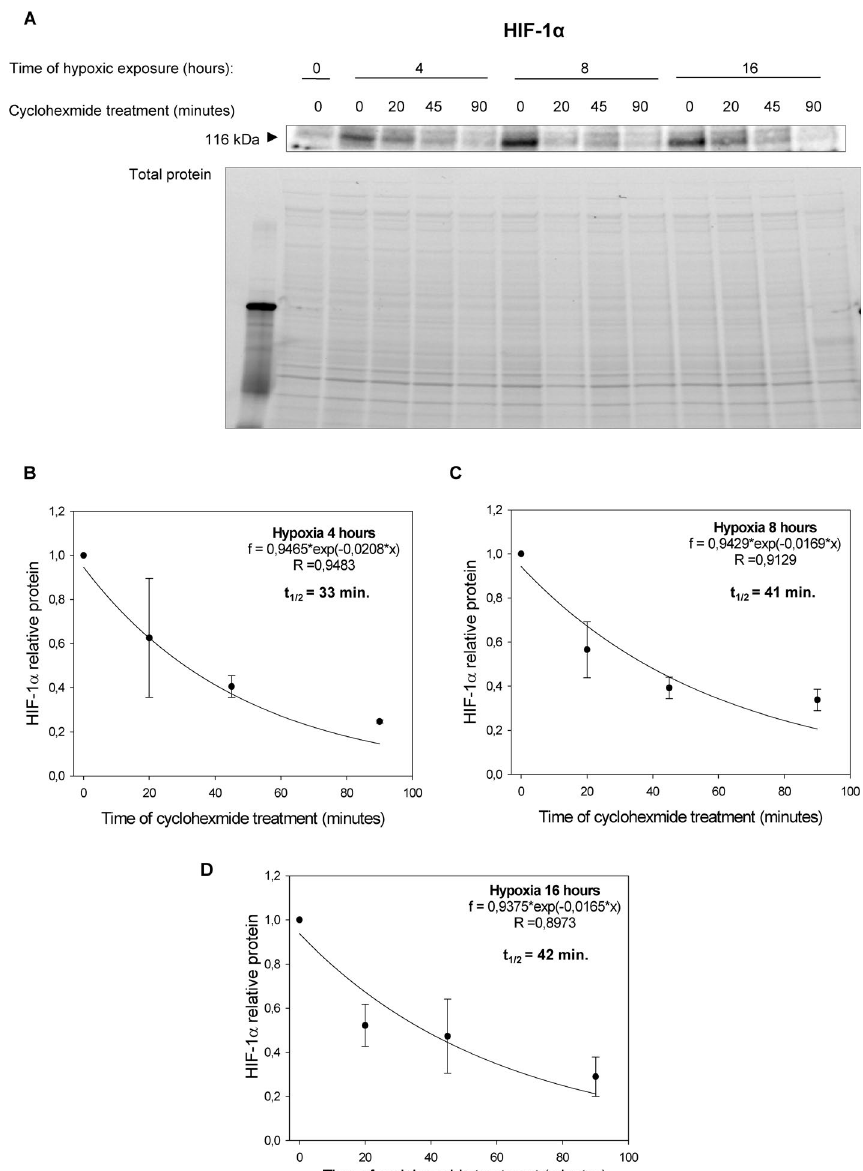
Fig. 2 Hypoxia effect on HIF-1α protein half-live. A HIF-1α half-live measurements were taken in HUVECs exposed to hypoxia for 4, 8, and 16 h (cells cultured in normoxia were the negative control). Cycloheximide was added to stop translation, after which protein lysates were collected, and HIF-1α levels at each time point were measured by western blot and normalized to total protein levels. Values for each time point were calculated from three individual samples generated in at least three independent experiments. The mathematical representation of HIF-1α protein levels for 4 h ( B ), 8 h ( C ) and 16 ( D ) hypoxia in HUVECs. The time points indicating relative HIF-1α levels were plotted as differences from HIF-1α levels at the initial time point (t 0). The protein half-lives were calculated from the exponential decay using the trend line equation = C/C 0 e –kdt (where C and C 0 are protein amounts at time t and at the t 0 , respectively, and k d is the protein = decay constant). The error bars represent SD. * P < 0.05 was considered